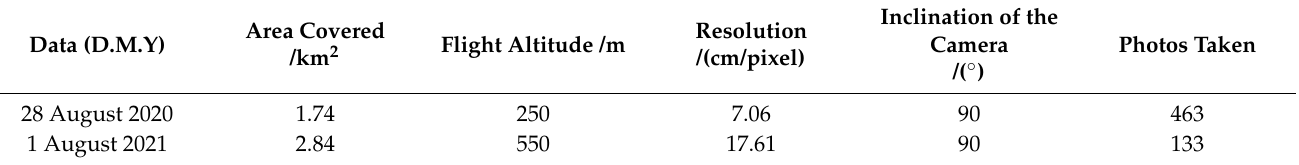
Table 2. UAV aerial survey